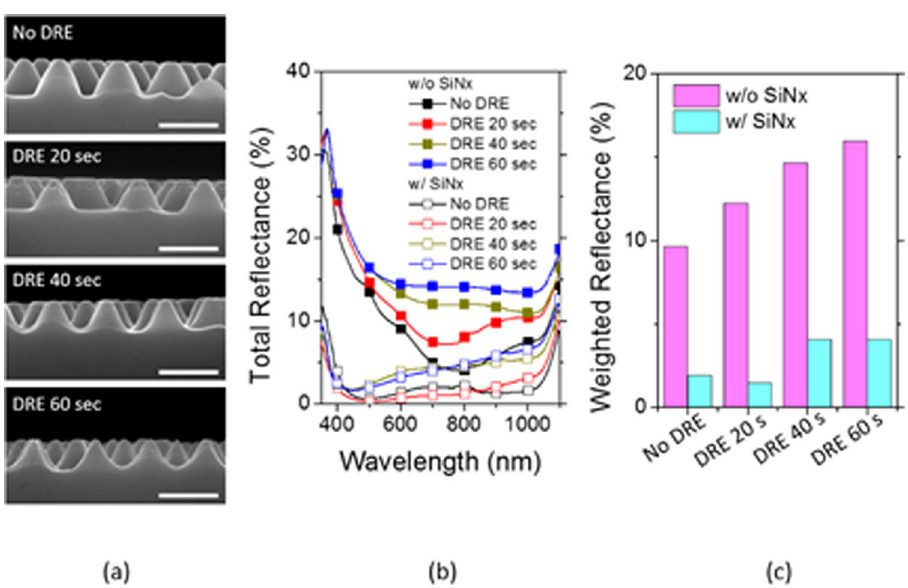
Figure 6. ( a ) Cross sectional SEM images of parabolic Si nanostructures with varying a DRE process time from 0 sec to 60 sec. ( b ) Reflectance curves and ( c ) weighted reflectances of parabolic Si nanostructures with or without SiNx. For comparison, reflectance values of a bare Si wafer is compared together. The scale bar is 500 nm for all the SEM